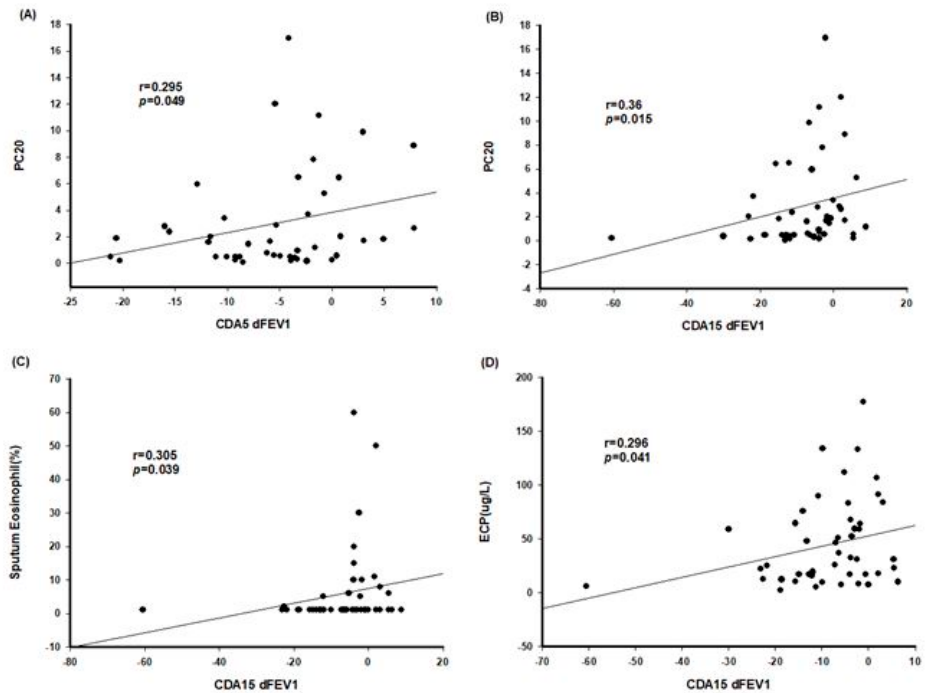
Figure 2. Correlation between CDA results and other factors in asthma patients. CDA—cold dry air;